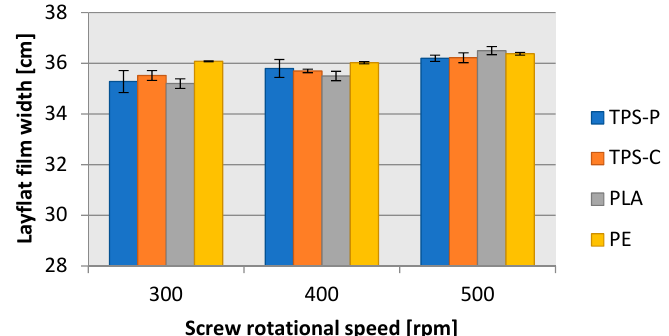
Figure 5. Dependence of the width of the obtained films on the rotational speed of the extruder screw.